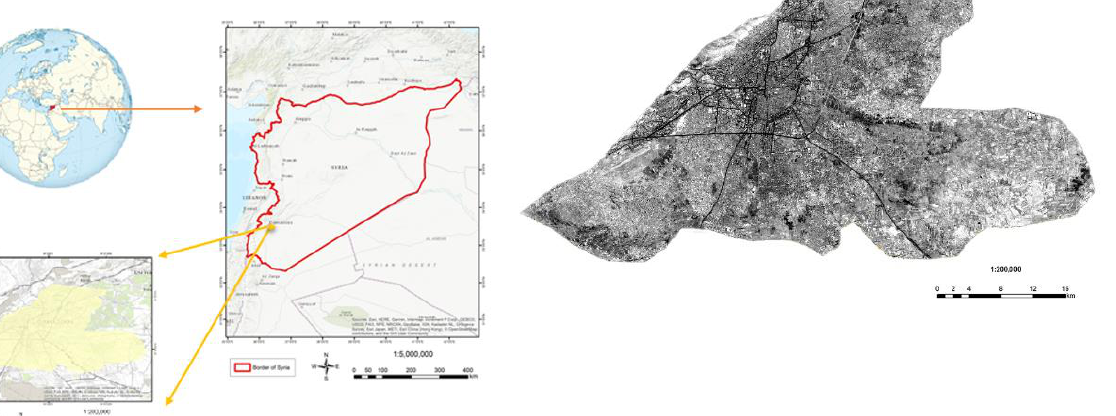
Figure 2 : Damascus, 20 August 2015 2A, 1 Meter Sentinel image.